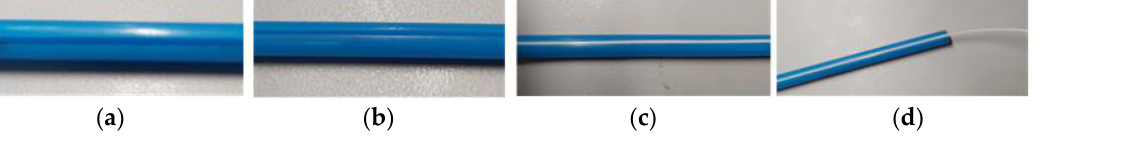
Figure 14. Fabrication process of FBG flexible sensor: ( a ) grooved; ( b ) cleaned; ( c ) protected; ( d ) leading.